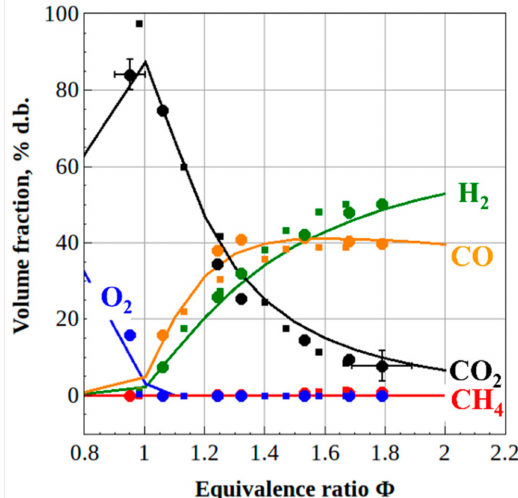
Figure 4. Measured (symbols) and calculated (curves) volume fractions of cooled dry detonation products of natural gas–oxygen mixture as a function of Φ for a 100-dm 3 reactor (circles) and 40-dm 3 reactor (squares) at f = 1 Hz, P ≈ 0.1 MPa. Calculations were made for the composition freezing temperature 2200 K. Bars show measurement